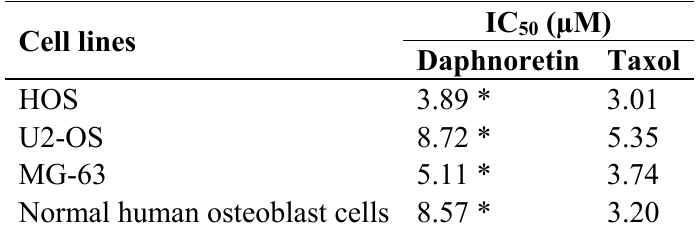
) values for daphnoretin towards HOS, U2-OS , Table 1. Inhibition concentrations 50% (IC 50 MG-63 and normal human osteoblast cells determined by MTT assay. The symbol * indicates significant differences ( p < 0.05) with respect to positive control (taxol). Results are represented means from three separate